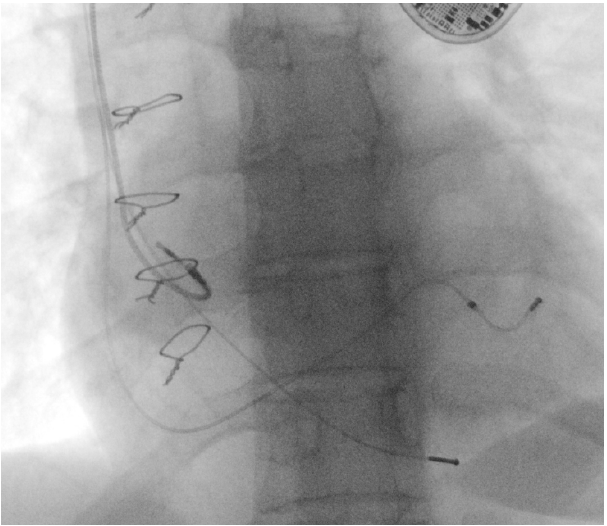
Figure 8. Chest X-ray at the time of admission at the hospital, with one lead positioned in the right atrial appendage, one on the apex of the right ventricle, and another one in the posterolateral vein. Pacemaker interrogation revealed 100% ventricular paced and no underlying ven- normal